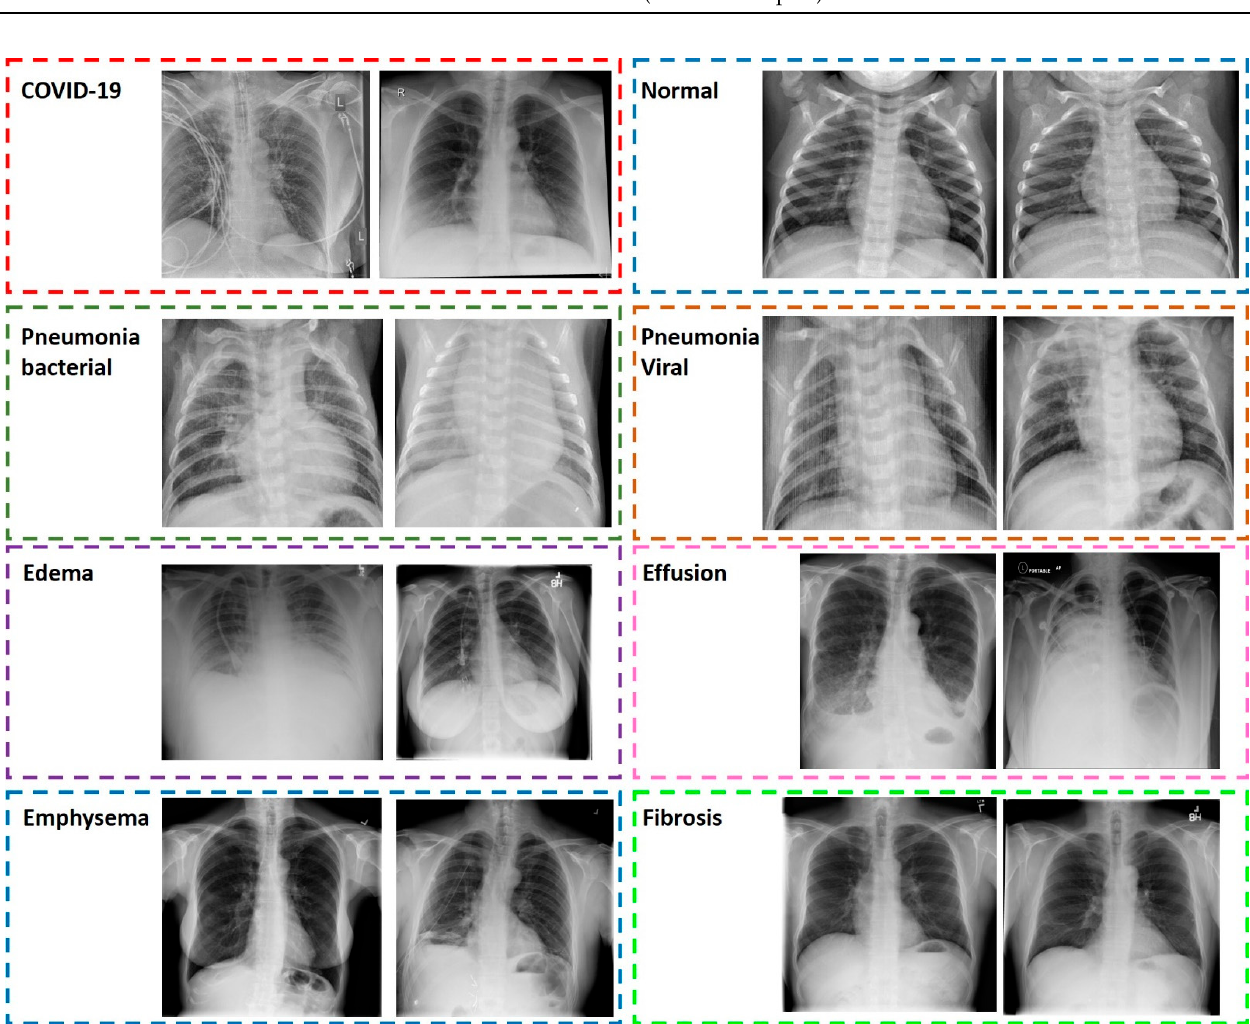
Figure 1. Samples of some classes belonging to abnormalities.